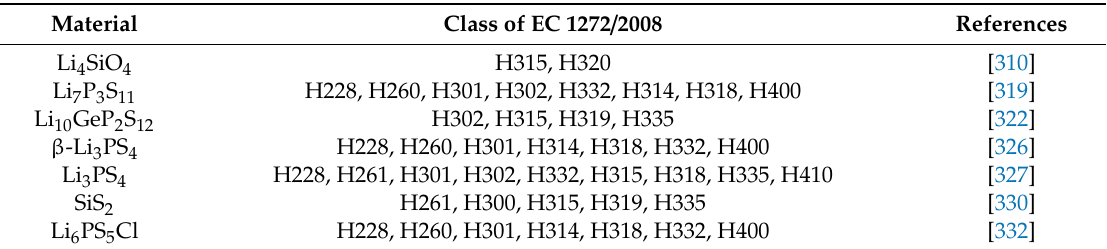
Table 11. Hazard statements of Li 4 SiO 4 , Li 7 P 3 S 11 , Li 10 GeP 2 S 12 , β -Li 3 PS 4 , Li 3 PS 4 , SiS 2 , and Li 6 PS 5